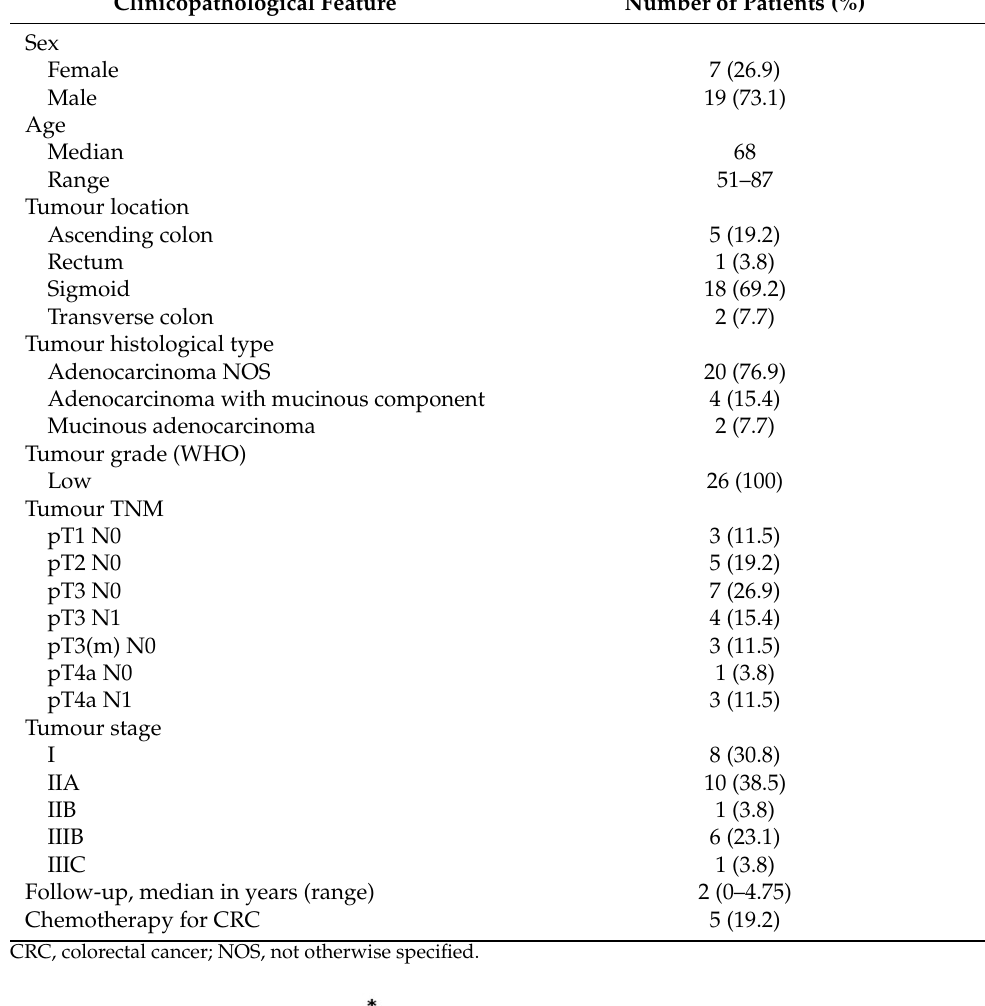
Table 1. Clinicopathological features of the 26 patients.